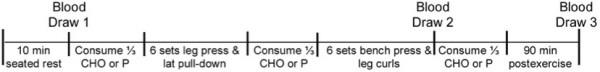
Resistance-exercise protocol timeline. CHO = carbohydrate; P = placebo.